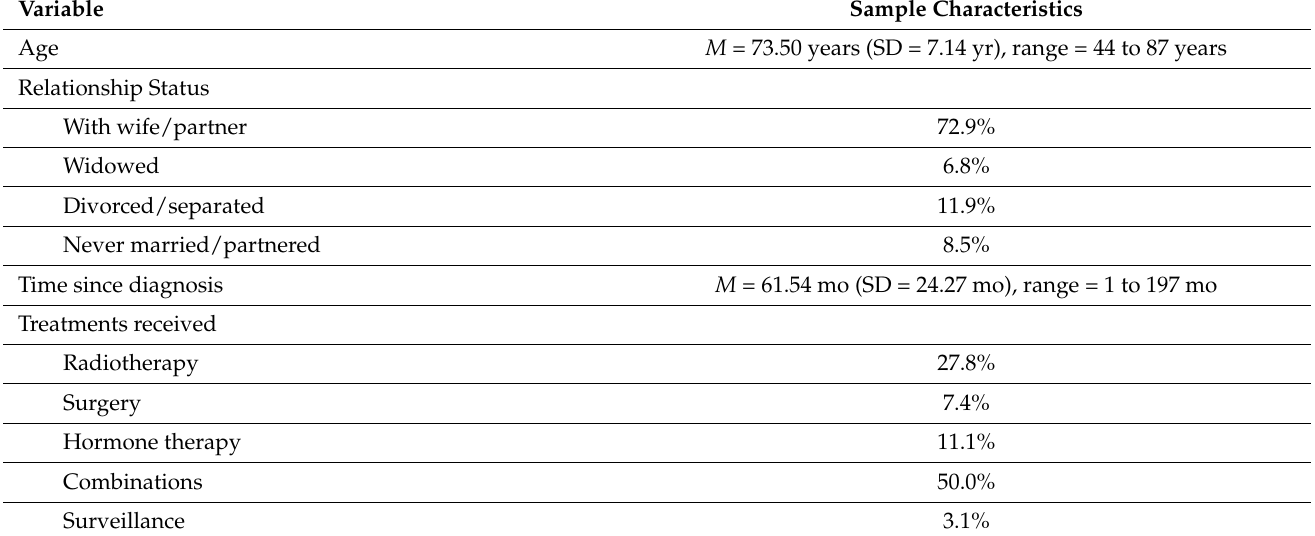
Table 1. Background and scale data for a sample of 55 patients with prostate cancer who reported a deterioration in sleeping quality following diagnosis and